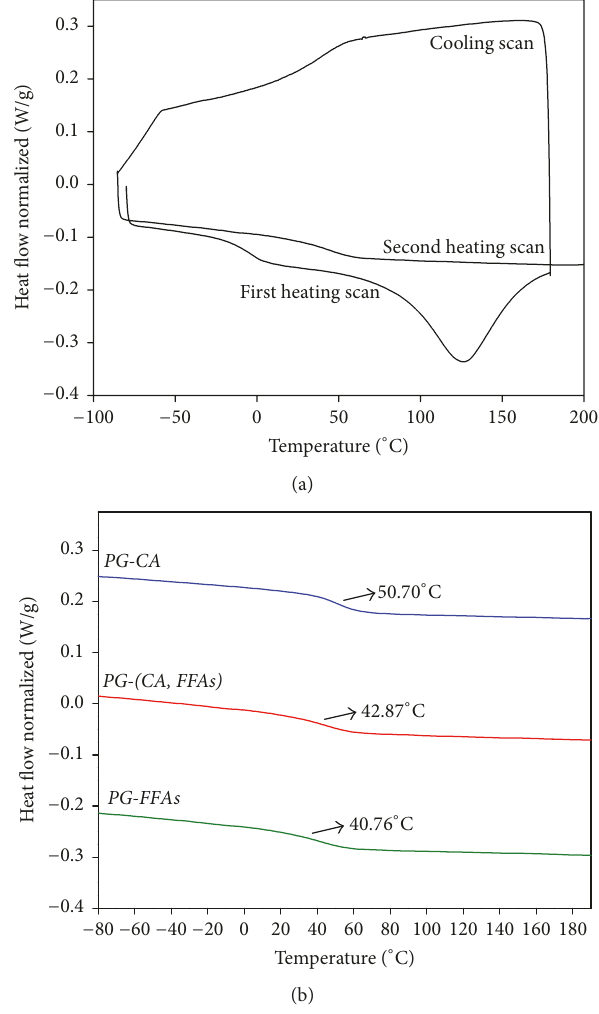
Figure 4: (a) First and second heating scan DSC result for hydrogels synthesized. (b) Hydrogels glass transition temperatures found in the second heating